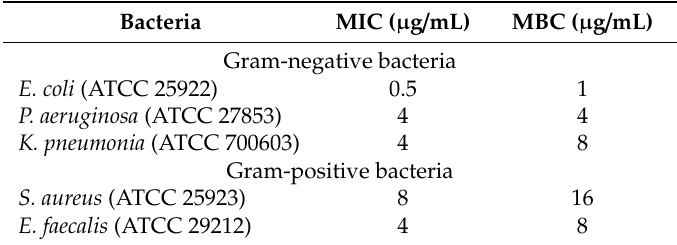
Table 2. Antimicrobial e ff ects of silver-containing nanocomposite 2 .